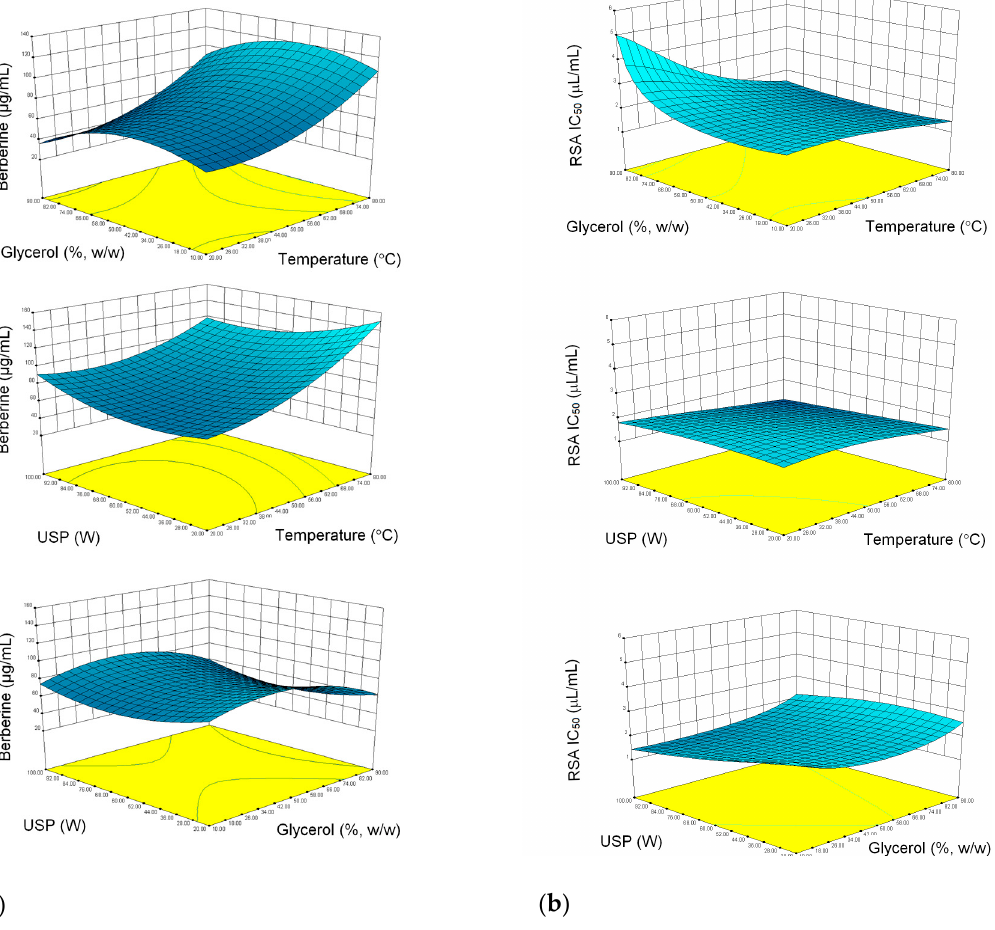
Figure 1. Response surface plots: influence of pairs independent variables on ( a ) berberine yield, and ( b ) radical scavenging activity (RSA IC 50 ). Table 4. Analysis of variance (ANOVA) for the fitted quadratic polynomial model for optimization of extraction